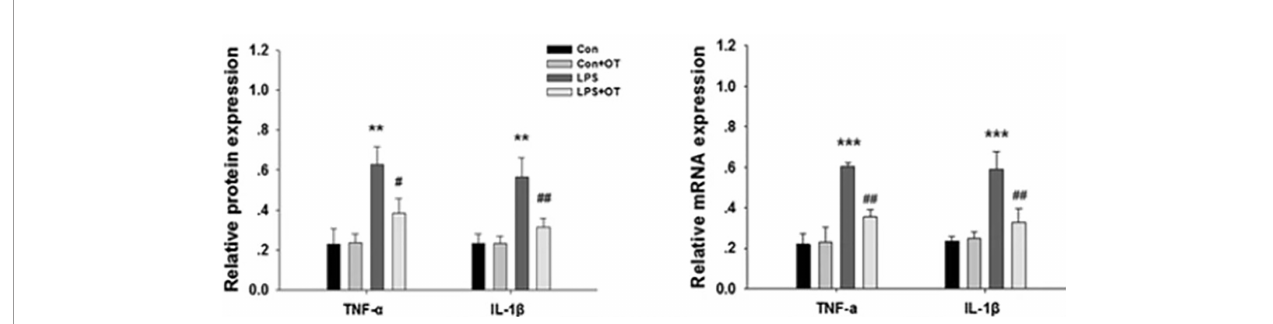
FIGURE 7 | Primary microglia were pre-treated with or without OT (1 m M) for 2 h followed by LPS (500 ng/ml) for 24 h. The levels of TNF- a and IL-1 b were analyzed by Western blotting. b -actin was used to evaluate protein loading. The levels of TNF- a and IL-1 b mRNA were analyzed by RT-PCR, and b -actin was used to evaluate protein loading. Each value was normalized to b -actin. Values represent the mean±S.D. of three independent experiments. **p<.01, ***p < 0.001 LPS vs Control; #p<0.05, ##p<0.01 LPS + OT vs LPS] [Figure from Springer Nature (90) permissible to re-use under a CC-BY